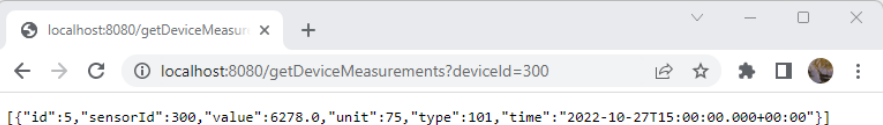
Figure 12. Access the web service endpoint using an HTTP GET parameter.